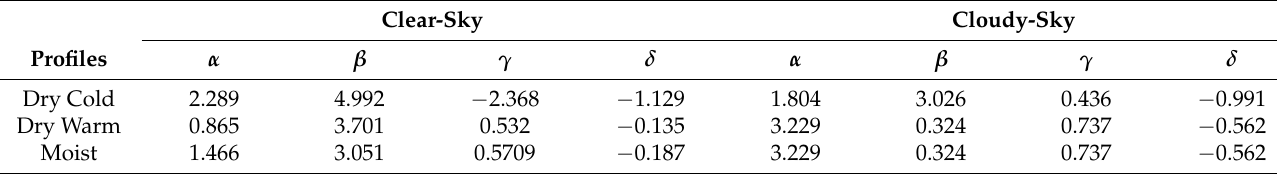
Table A2. Calibrated parameters for the LSA model using ERA5 inputs and observed DLR (BSRN and ARM) for the different atmospheric profiles under clear and